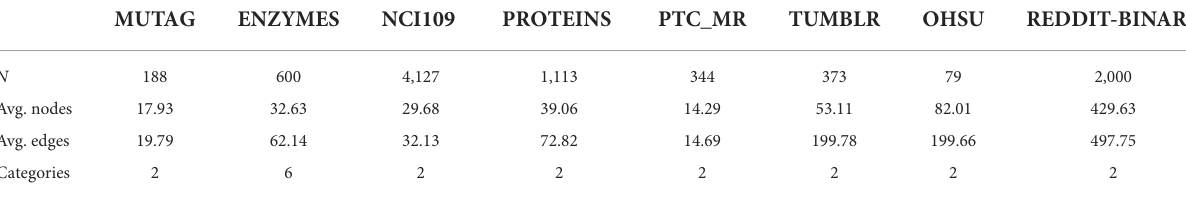
TABLE 4 Graph statistics for all the considered